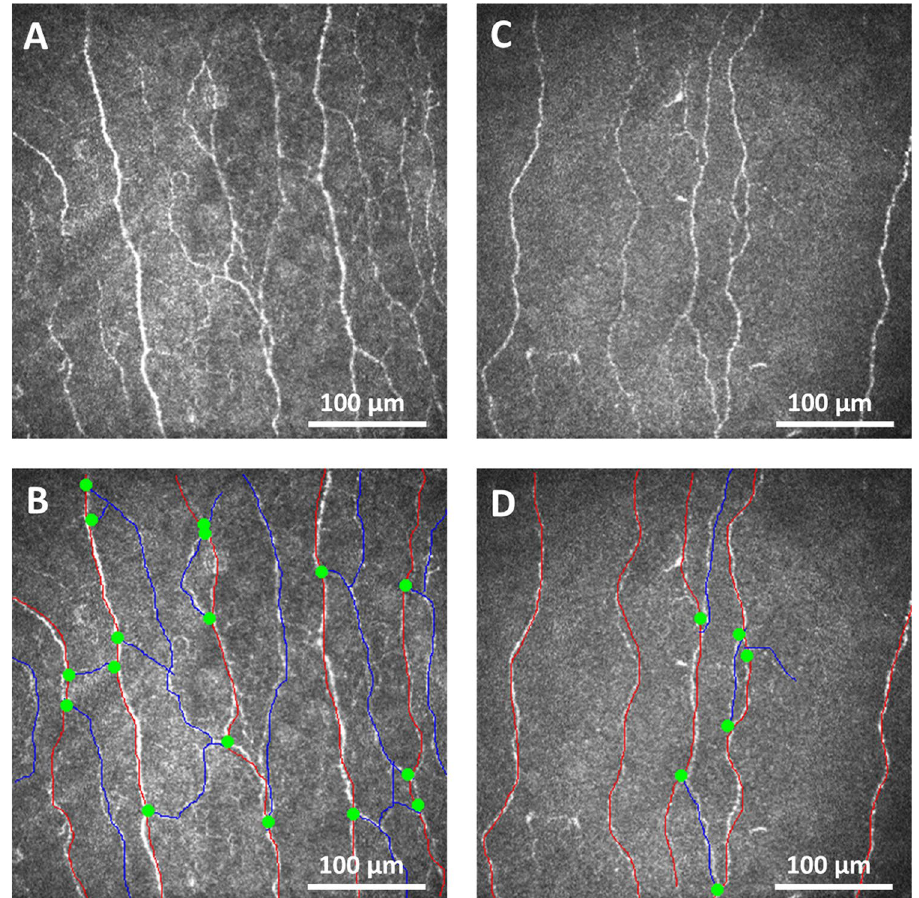
Figure 1. Corneal nerve fiber morphology in a healthy control and subject with schizophrenia. Corneal confocal microscopy (CCM) images of the sub-basal nerve plexus from a health control subject ( A ) with the nerves traced ( B ) and a subject with schizophrenia ( C ) with nerves traced ( D ) showing reduced corneal nerve fiber density (red lines), branch density (green dots) and length (red and blue lines) in the subject with schizophrenia compared to the healthy